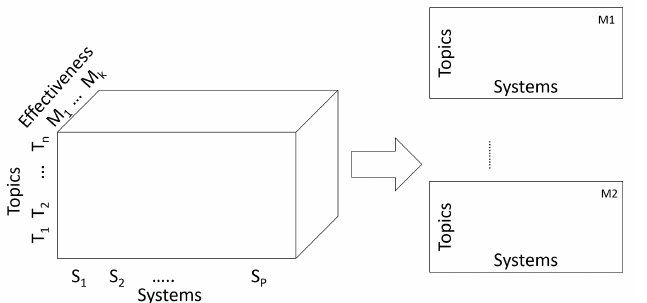
Figure 3. The 3D matrices obtained from participants’ results to shared ad hoc information retrieval tasks that report effectiveness measurements for systems, topics, effectiveness measures can be transformed into 2D matrices that fit many data analysis methods.